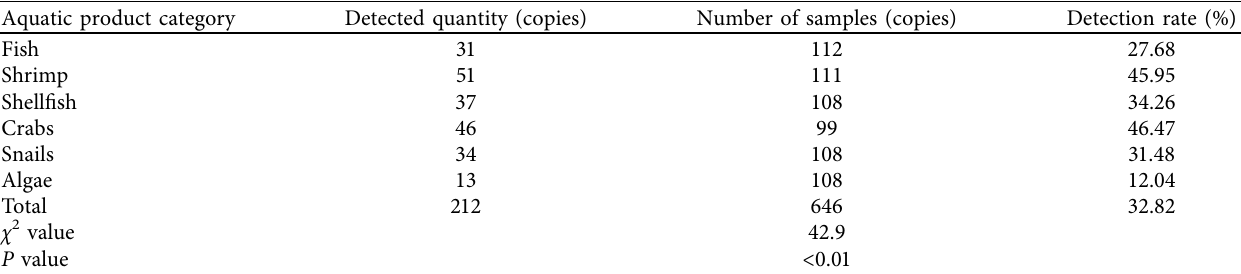
Table 5: Detection rate of pathogenic Vibrio in various aquatic products.